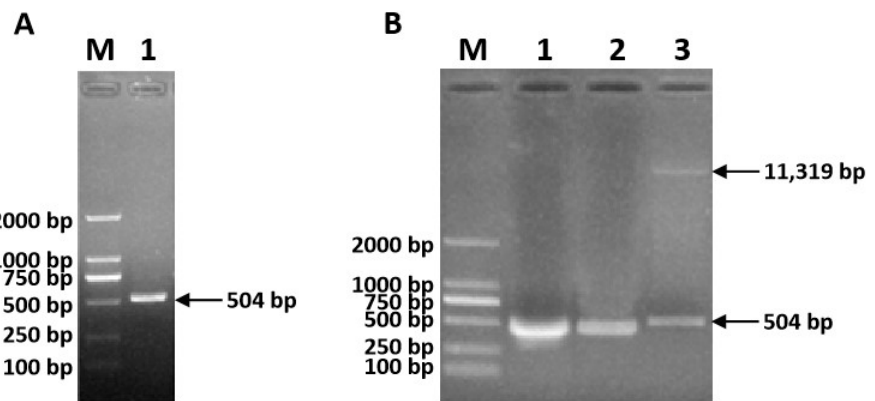
Figure 6. Construction and verification of recombinant plasmid pCAMBIA3301- GmPLMT based on PCR ( A ) and double restriction endonuclease digestion of HindIII and BamHI ( B ). Lane M represents DL2000 DNA marker. Lane 1 in ( A ) indicates GmPLMT of 504 bp. Lanes 1–3 in ( B ) represent the PCR product based on the recombinant plasmid pCAMBIA3301- GmPLMT ( GmPLMT of 504 bp), the bacterial liquid PCR product ( GmPLMT of 504 bp), and the products of the double restriction endonuclease digestion of plasmid based on HindIII and BamHI (504 bp of GmPLMT and 11,319 bp of the plasmid).